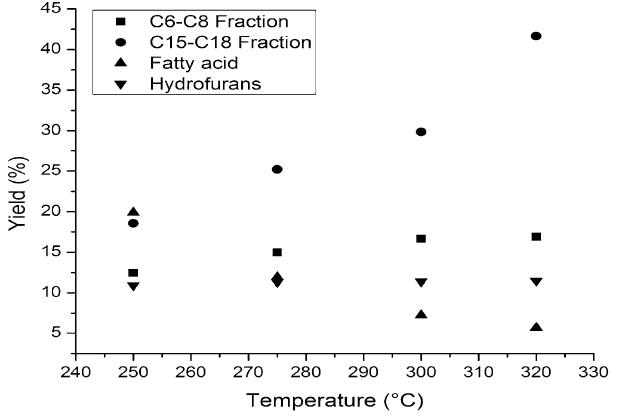
Figure 8. The influence of temperature over the yields in products composition of liquid organic phase.